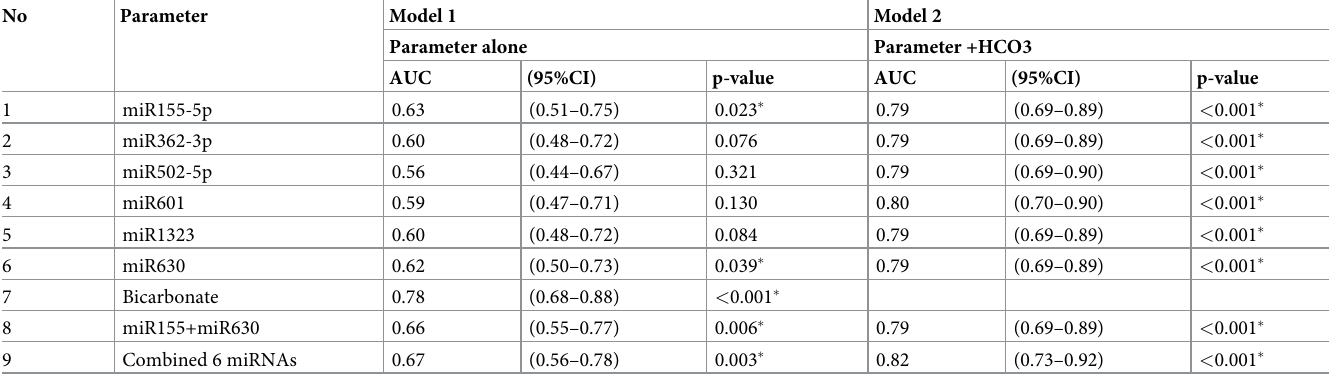
Table 2. The area under the curve (AUC) for the association between serum miRNAs and severe leptospirosis. No